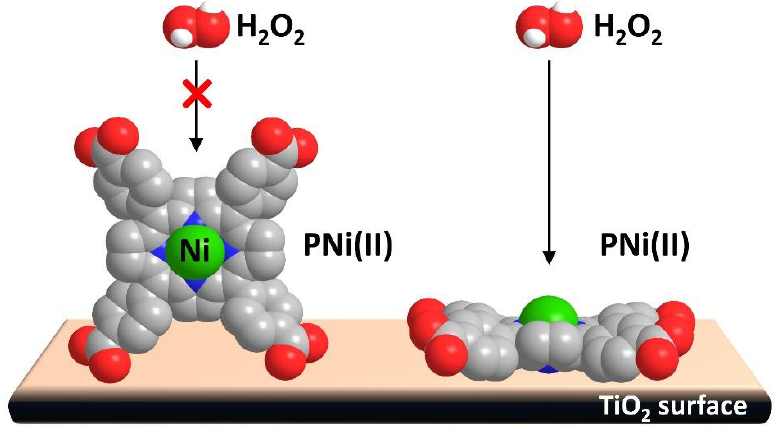
Figure 17. Nickel tetra(4-carboxyphenyl)porphyrin (TCPPNi) geometry and interaction with TiO 2 surface and H 2 O 2 . Adapted from reference [82] with permission from Elsevier, copyright 2016.